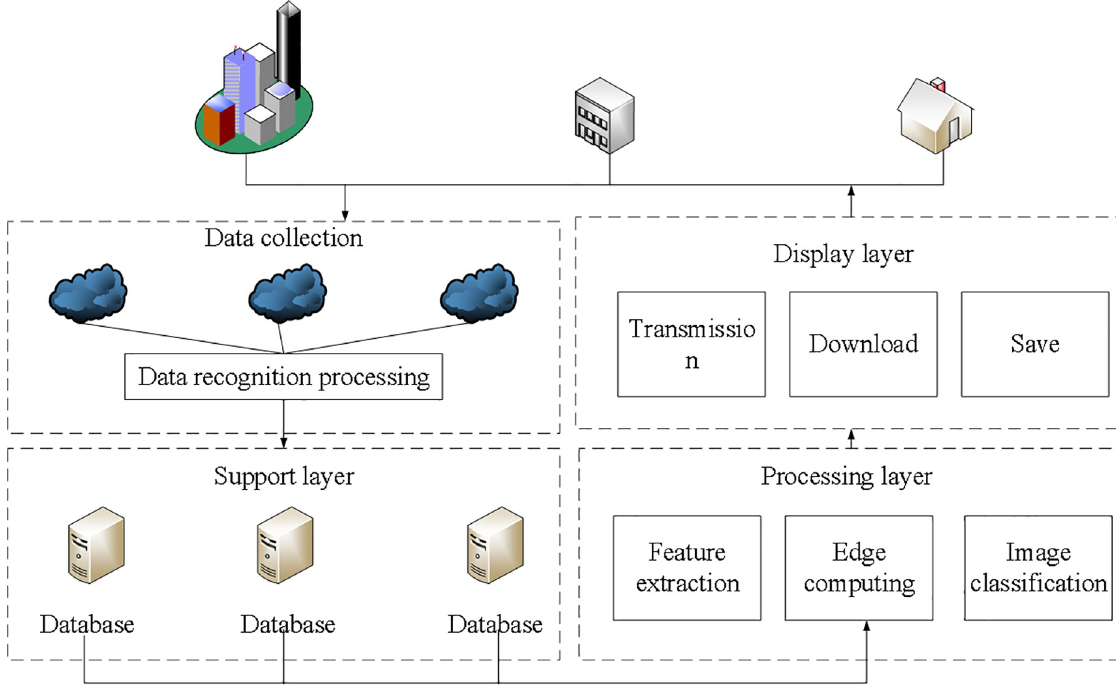
Fig 1. Digitized landscape architecture design scheme based on edge